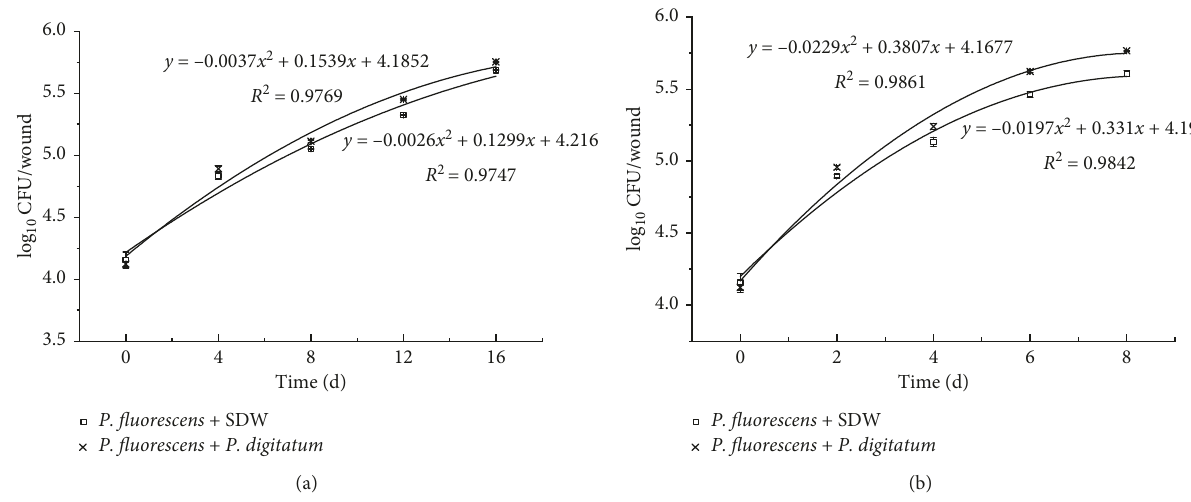
Figure 4: Population dynamic of P. fluorescens in citrus wounds at 4 ° C for 16 days (a) and 20 ° C for 8 days (b).